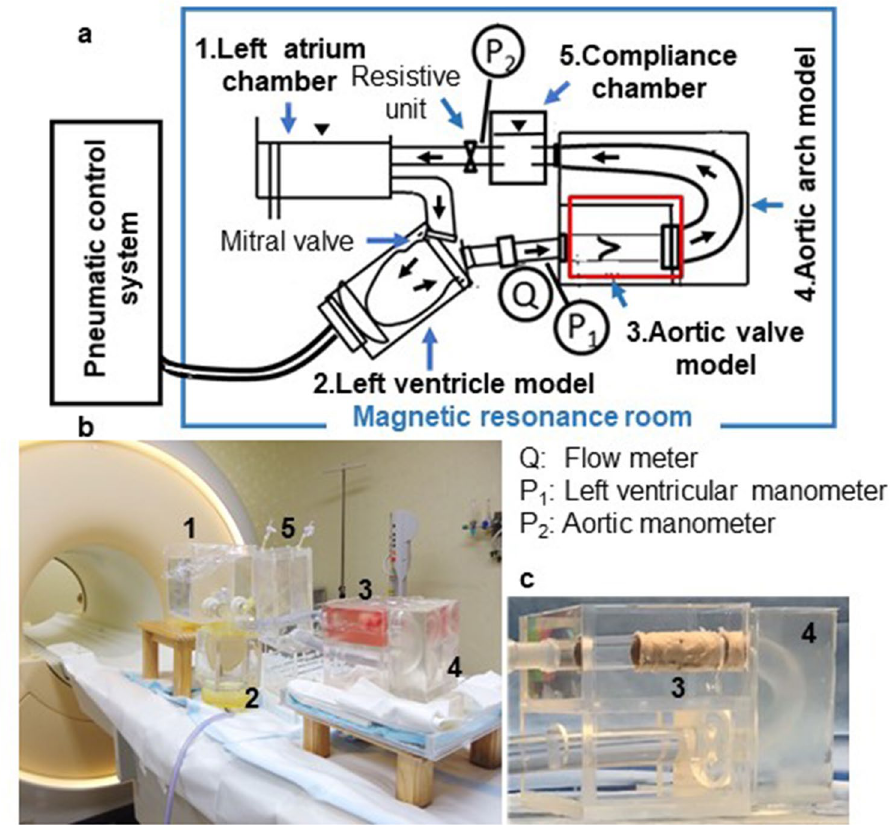
Figure 3. Magnetic resonance imaging (MRI)-compatible pulsatile flow and pressure circulation system. ( a ) MRI-compatible circulation system composed of a left atrium chamber, mitral valve model, left ventricle model, aortic valve model, aortic arch model, compliance chamber, and resistive unit. The pneumatic control system, connected via tubing to a left ventricle model, is placed outside the magnetic resonance room. ( b ) The setup on the magnetic resonance examination table. ( c ) Aortic arch model incorporating an aortic valve